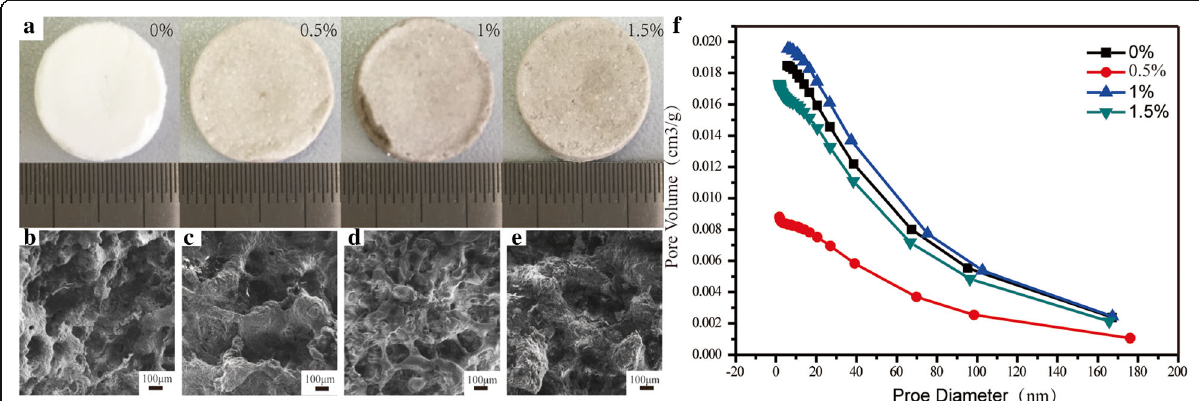
Fig. 2 a Optical image of the synthesized nHAC/PLGA/GO scaffolds with different amount of GO. b – e SEM images of b nHAC/PLGA, c nHAC/PLGA/